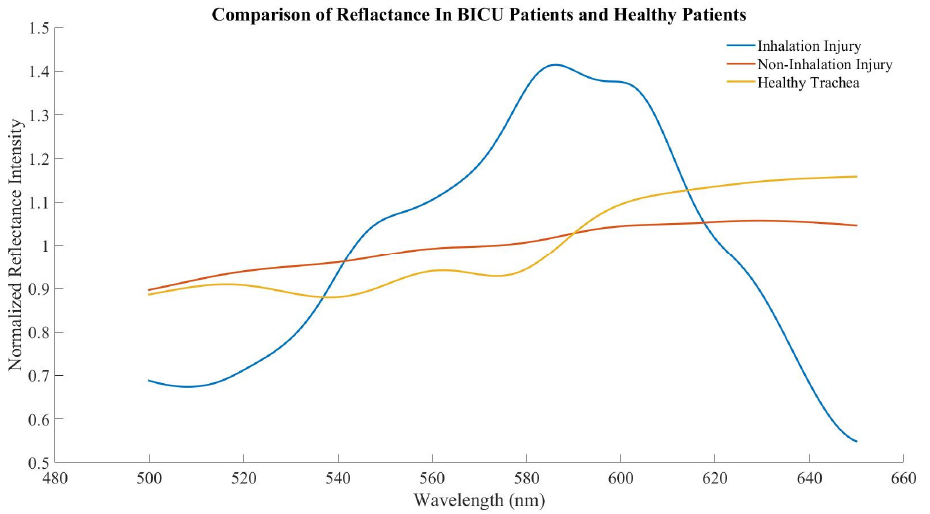
Figure 4. Averaged tracheal spectra from healthy human subjects, BICU subjects with inhalation injury, and BICU subjects without inhalation injury.